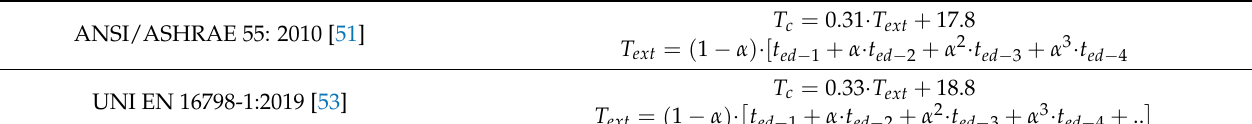
Table 1. Equations of adaptive models from